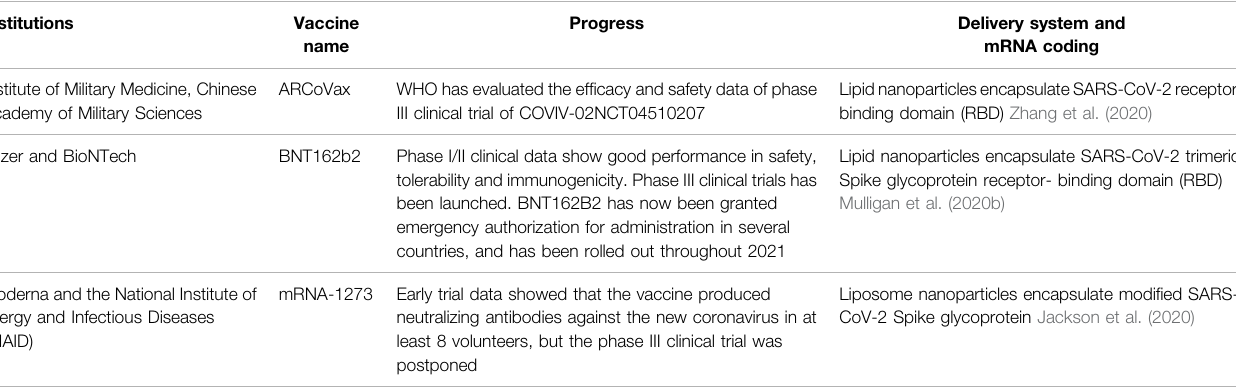
TABLE 2 | mRNA COVID-19 vaccines undergoing clinical